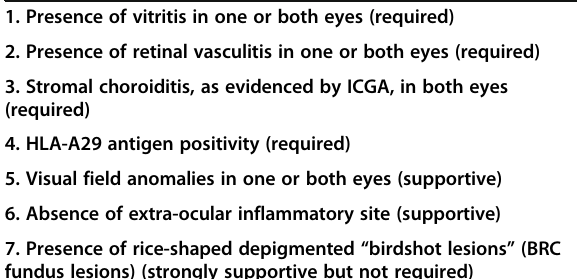
Table 5 European based simplified diagnostic criteria for